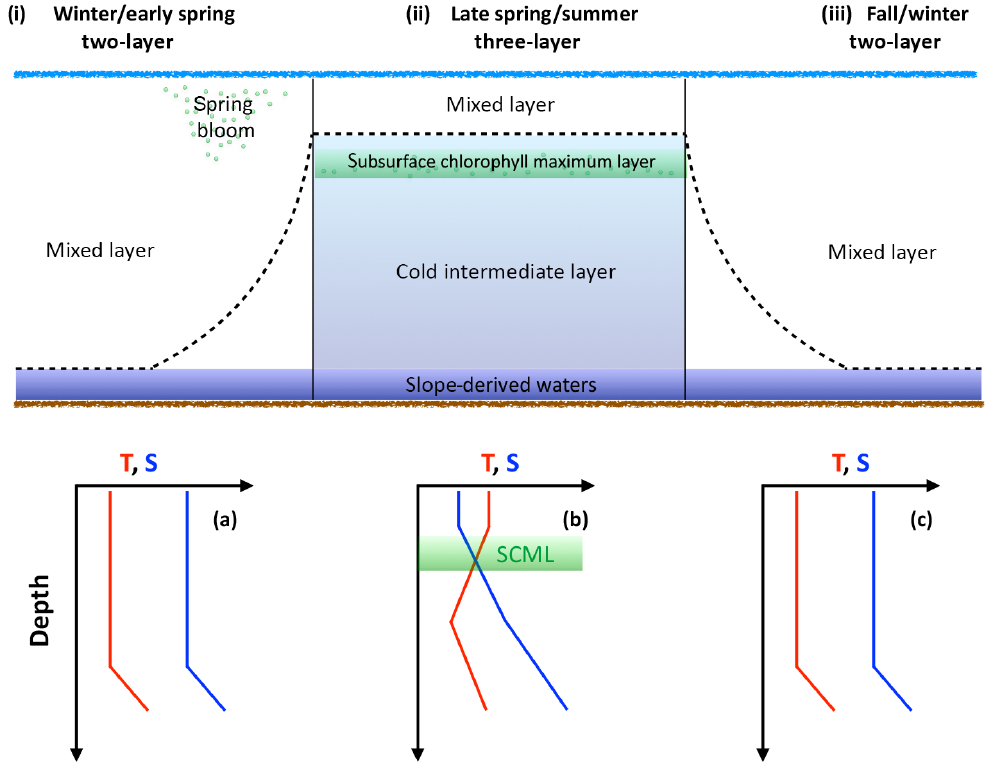
Figure 3. Schematic demonstrating the evolution of the water column over the course of the year. The dashed line intersecting panels (i) , (ii) , and (iii) represents the mixed layer. SCML in green represents the subsurface chlorophyll maximum layer. Temperature and salinity profiles provide an idealized view of the upper water column; panel (a) corresponds to panel (i) , (b) to (ii) , and (c) to (iii)